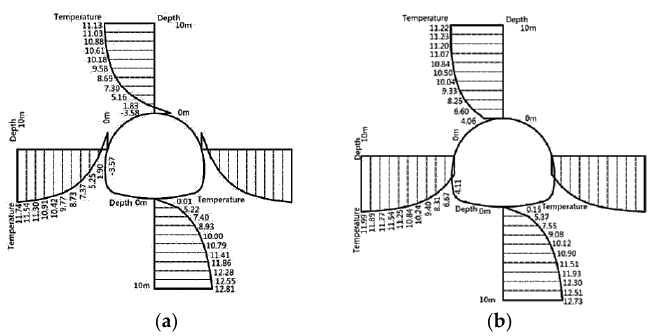
Figure 13. Average temperature of surrounding rock in December: ( a ) without heat-insulating layer (°C) and ( b ) with heat-insulating layer (°C) (cross-section K0 + 015). ( ◦ C) and ( b ) with heat-insulating layer ( ◦ C) (cross-section K0 + 015).